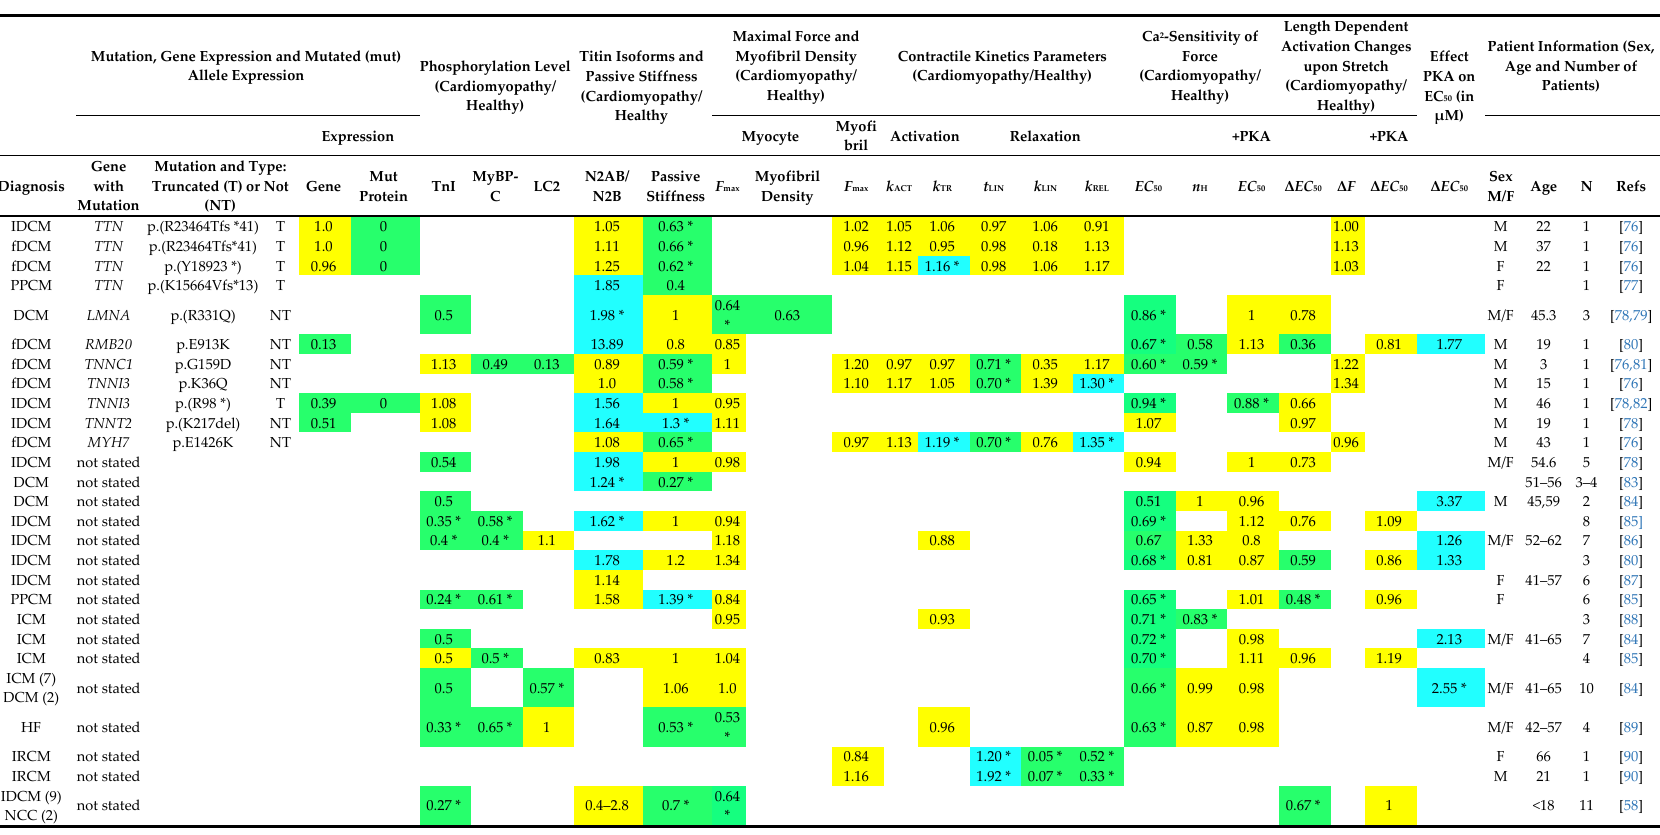
Table 2. Contractile characteristics of dilated and other cardiomyopathy heart muscles.